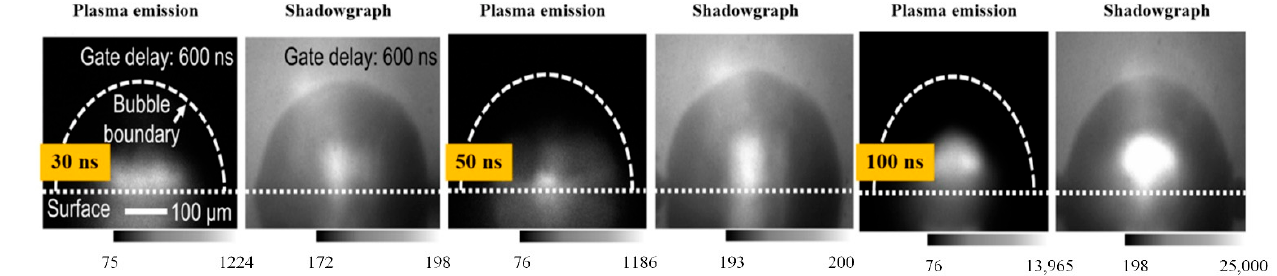
Figure 5. Time duration of plasma emission, shock wave formation, and bubble collapse during the LAL process. Reprinted/adapted with permission from Ref. [36]. Copyright 2015, Elsevier.